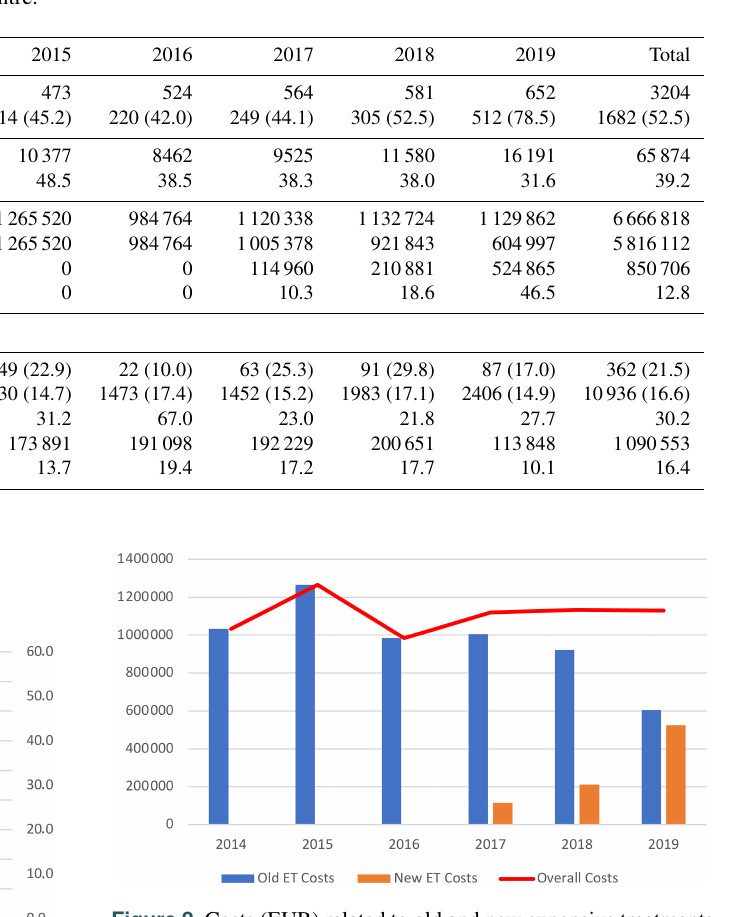
Figure 2. Costs (EUR) related to old and new expensive treatments and total costs. ET – expensive